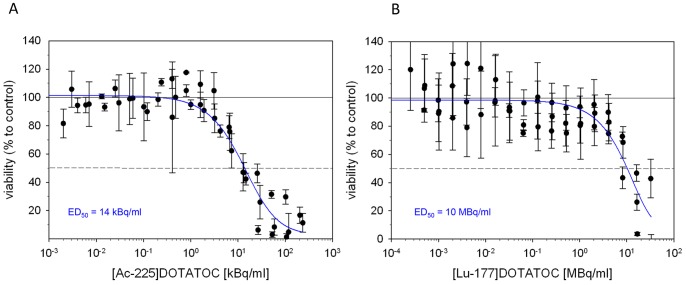
Viability of AR42J cells at 48225Ac-DOTATOC (A) and 177Lu-DOTATOC (B).